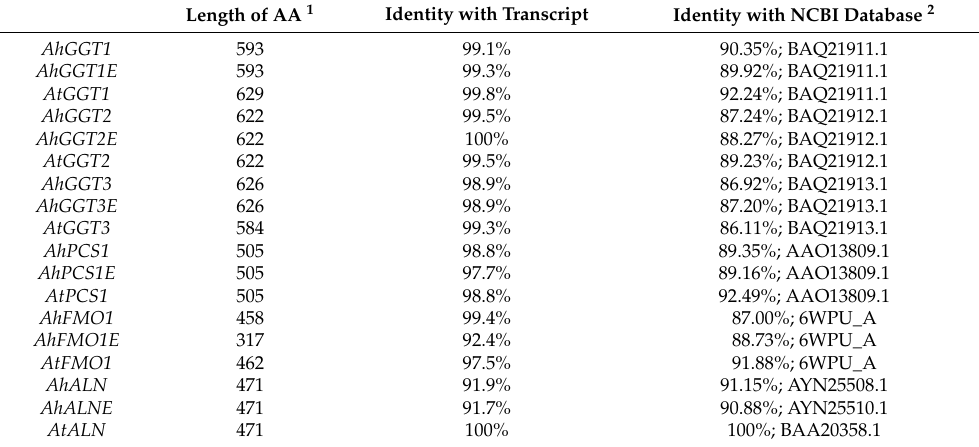
Table 3. Sequence information of biosynthetic genes of garlic odor